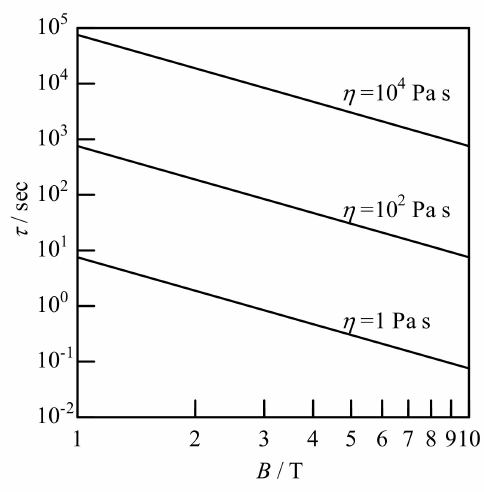
Figure 8. Alignment rate τ as a function of magnetic flux density B under anisotropic diamagnetic susceptibility of | χ a | = 10 − 6 . Viscosity of media is shown in the